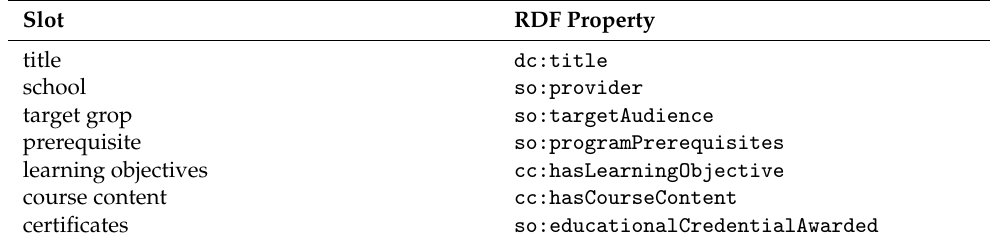
Table 3. Vocabulary used for translating slot filling results to RDF